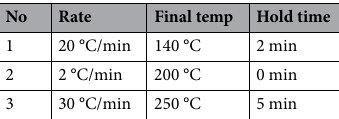
Table 2. GC oven temperature